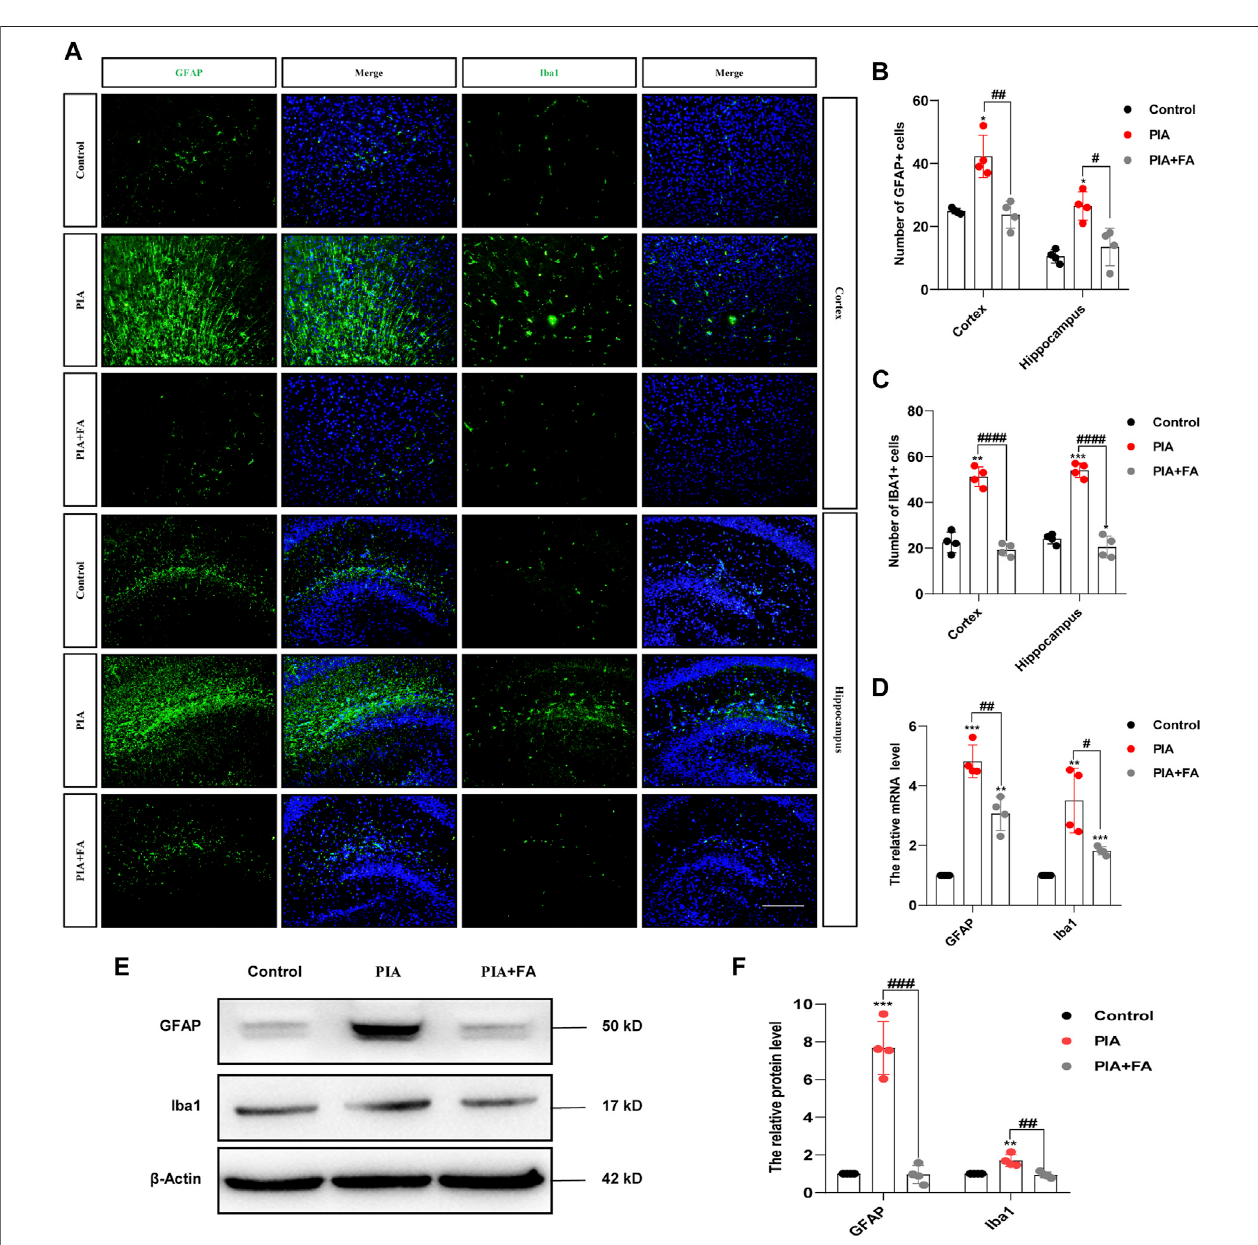
FIGURE 2| FA inhibited the activation of astrocytesand microglia in the brain of neonatal mice. (A) Cortex and hippocampal sections were stained with GFAP (the astrocytesmarker) orIba1(the microglia marker) (green), and nucleiwerestainedwithDAPI tolocalizeandassess theactivationlevels ofastrocytesand microglia. (B,C) Quanti fi cation oftheGFAP-positivecellsand Iba1-positive cells. (D) Quanti fi cationofthemRNAlevels ofGFAPand Iba1intheneonatalmice brain. (E,F) Representative imagesand quanti fi cation ofWestern blotting analysis of GFAP and Iba1 expression in the neonatalmouse brain (scale bar: 50 μ m). Data: mean ± SEM; * p < 0.05, ** p < 0.01, *** p < 0.001 versus the control group; # p < 0.05, ## p < 0.01, ### p < 0.001, #### p < 0.0001 versus the PIA group; n = 4 per group (one-way